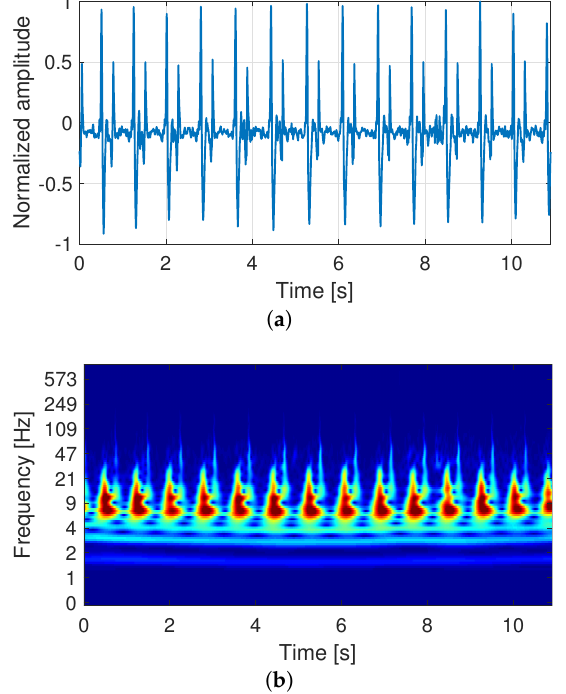
Figure 4. ( a ) Example of a raw signal of the carotid sounds recorded from user U1 during controlled apnea. ( b ) Continuous wavelet transform (CWT) spectrum computed from ( a